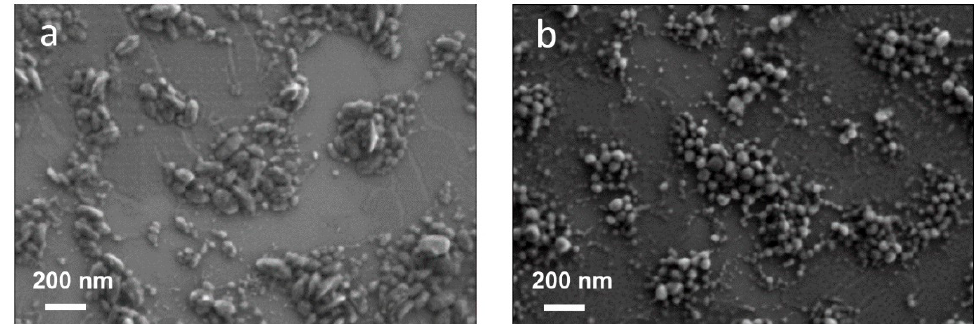
Figure 2. Representative images of scanning electron microscopy (SEM) of PFO_CNPs ( a ) and F8BT_CNPs ( b ). F8BT_CNPs ( b